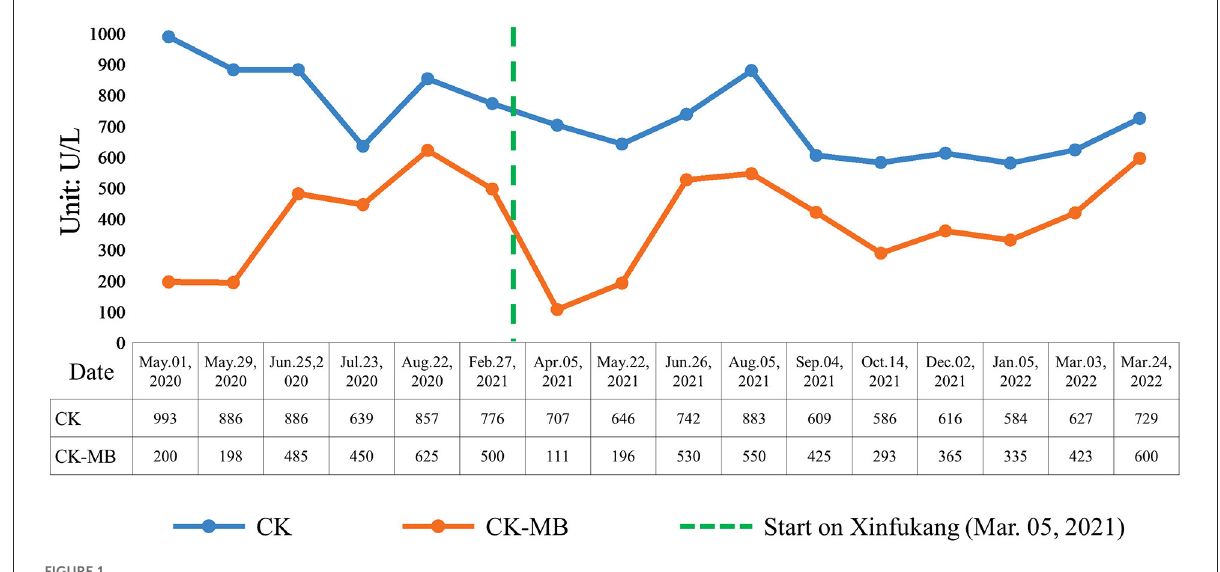
FIGURE1 Changes of serum CK and CK-MB levels in the child.